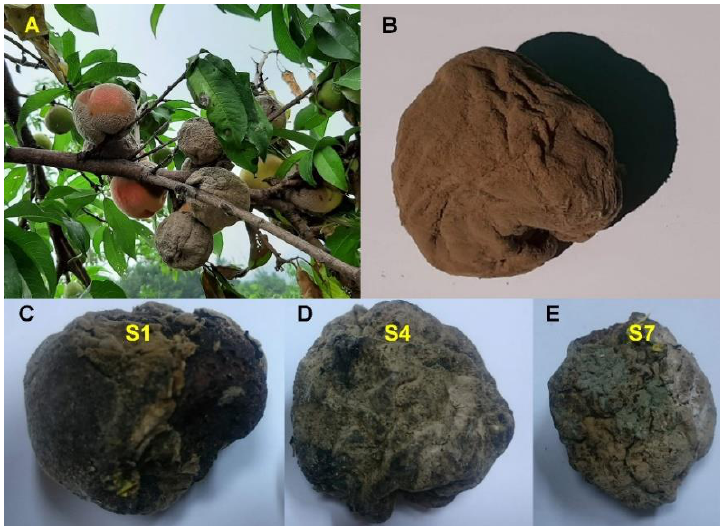
Figure 1. Peach fruits infected by fungi and the mummified peach fruits. ( A ) Peach fruits infected by fungi clinging to the peach branch. ( B ) Brown rot on a peach fruit. Mummified peach fruit samples, S1 ( C ), S4 ( D ), and S7 ( E ) used for next-generation sequencing.